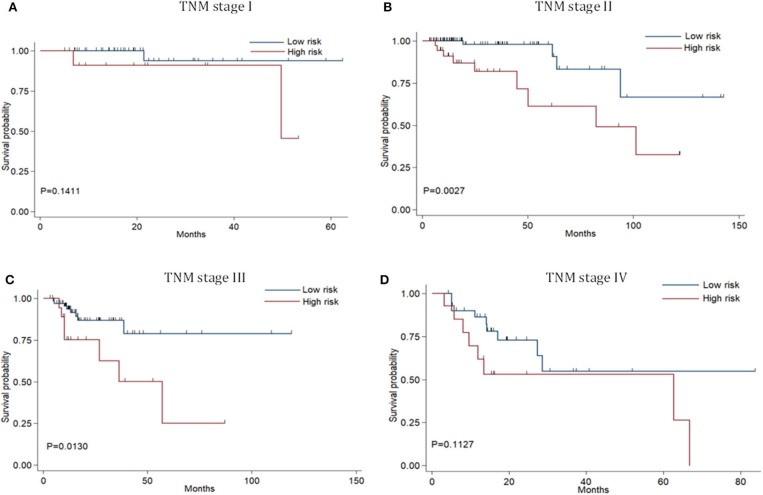
Stratified analysis of six-miRNA-based signature for colon adenocarcinoma patients in TNM stage. Kaplan-Meier curves of over survival for CA patients in TNM stage I (A),TNM stage II (B),TNM stage III (C), and TNM stage IV (D).